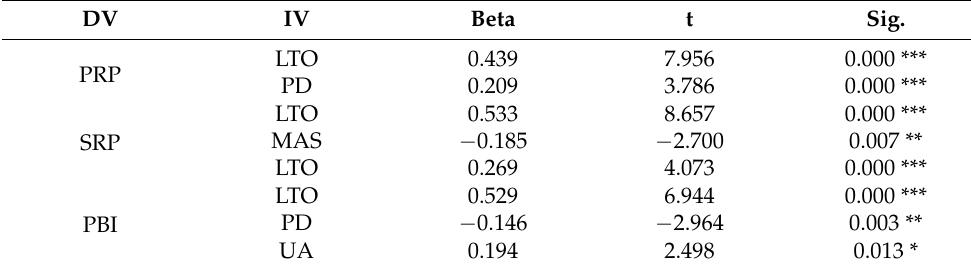
Table 8. The impact of cultural differences on health perception in the US.